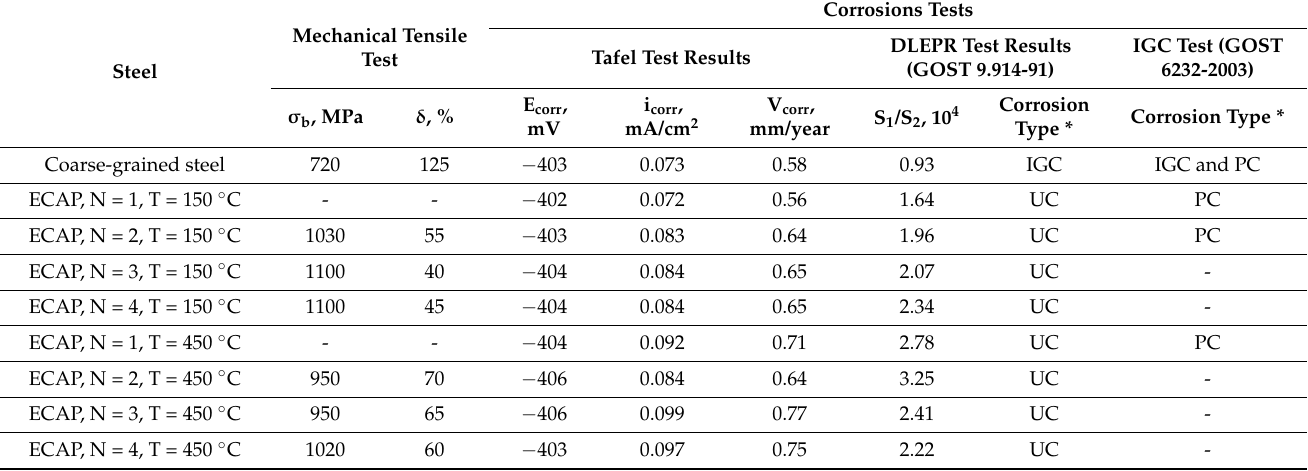
(Table 1). ECAP at higher temperatures (450 ◦ C) resulted in an insufficient decrease in σ b to 1020 MPa and an increase in elongation to failure to ~60%. Table 1. Results of the mechanical tests and corrosions tests of CG and UFG